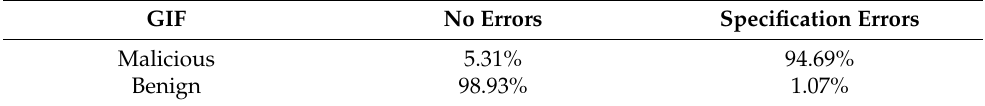
Table 2. The proportion distribution of normative inspections of GIF